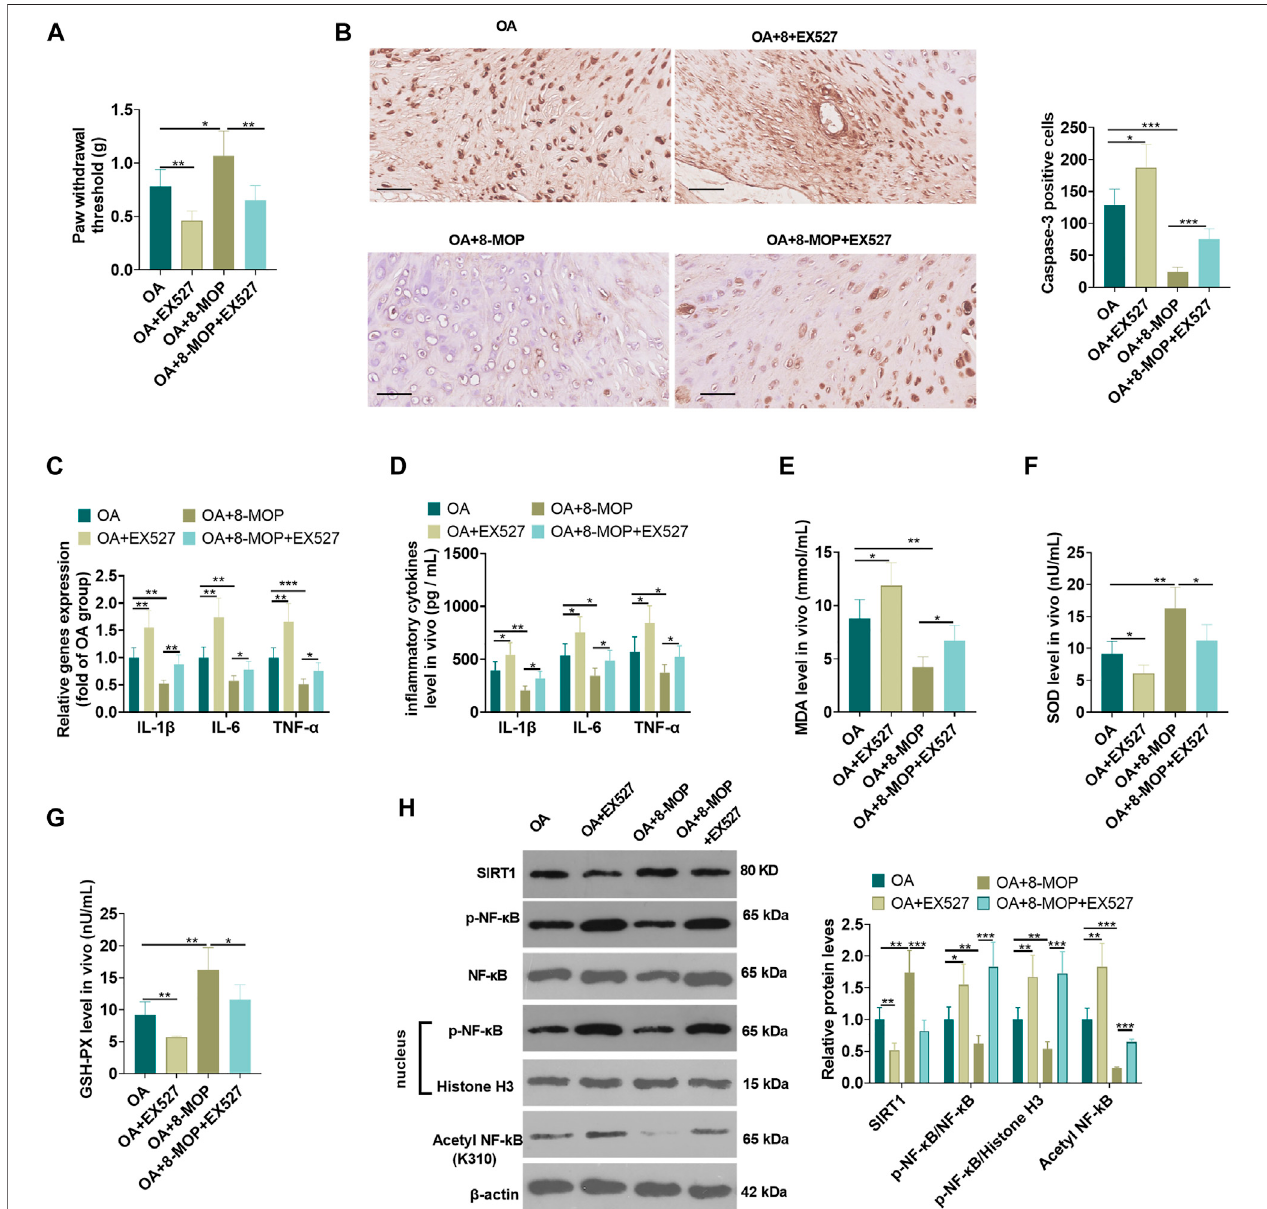
FIGURE 8 | Inhibition of SIRT1 attenuated the protective effect of 8-MOP on OA rats. The Wistar rat OA model was established by intraarticular injection of 4% papain.Rats weredivided intofourgroups: The OAgroup,the OA+EX527(20 μ mol/kg bodyweight) group, theOA+8-MOP(30 μ mol/kg, i.p.) group,the OA+EX527 (20 μ mol/kg body weight) +8-MOP (30 μ mol/kg, i.p.) group. (A) . The PWT was measured to assess the level of bone pain in rats. (B) . Caspase3-positive cells were counted by IHC. (C – D) . The levels of in fl ammatory cytokines (IL-6, TNF- α , and IL-18) were detected by qRT-PCR and ELISA. (E – G) : The oxidative stress factors (MDA, SOD, and GSH-PX) in the OA site were measured by the MDA, SOD, and GSH-PX detection kits. (H) . The expression of SIRT1, p-NF- κ B p65 protein levels and acetylation NF- κ B p65 was measured by qRT-PCR and Western blot, respectively. * p < 0.05, ** p < 0.01, *** p < 0.001. ( n (cid:1) 5).